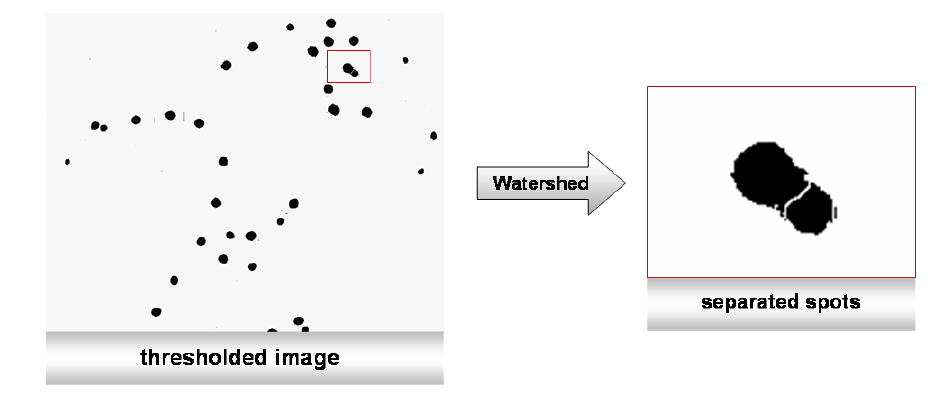
Figure 4a. Overlapping items (fluorescence-labeled nuclei) can be separated using the watershed method. The image from Figure 3 contains nuclei that are localized so closely together that they need to be separated by the watershed method describe in the main text.